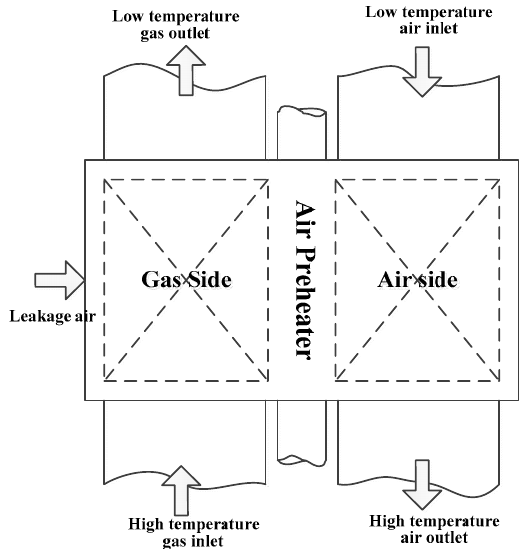
Figure 1. The schematic diagram of the air preheater.